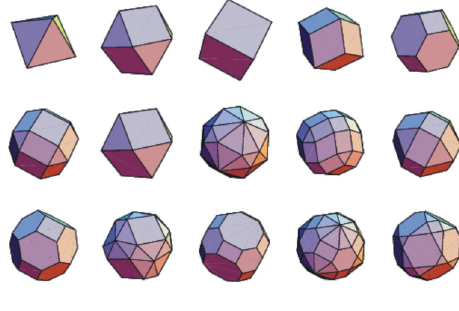
Fig. 6. Waterman’s polyhedrons (source: mathworld.wolfram.com/WatermanPolyhe- dron.html) Fig. 7. Myriahedron and its net according to van Wijk (http://www.win.tue.nl/~vanwijk/myriahedral/)